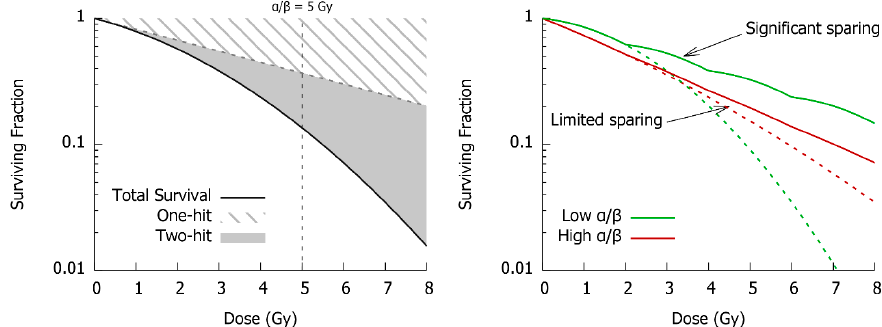
Figure 1. Left: Illustration of linear-quadratic dose response model. This postulates that cell survival has a “one-hit” linear component, and a “two-hit” quadratic component, which contribute varying amounts with varying doses. While simple, this model has been shown to encapsulate many aspects of radiation responses. Right: As an illustration, it provides an intuitive explanation for the benefits of fractionation, where in low 𝛼/𝛽 tissues the “shoulder” is repeated, giving rise to significant sparing, while in high 𝛼/𝛽 tissues, much less sparing is seen. However, this model has only limited scope for mechanistic applications.